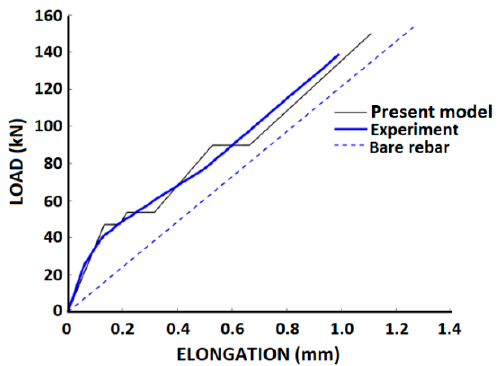
Figure 12. Comparison with Houde and Mirza: prismatic URCE.